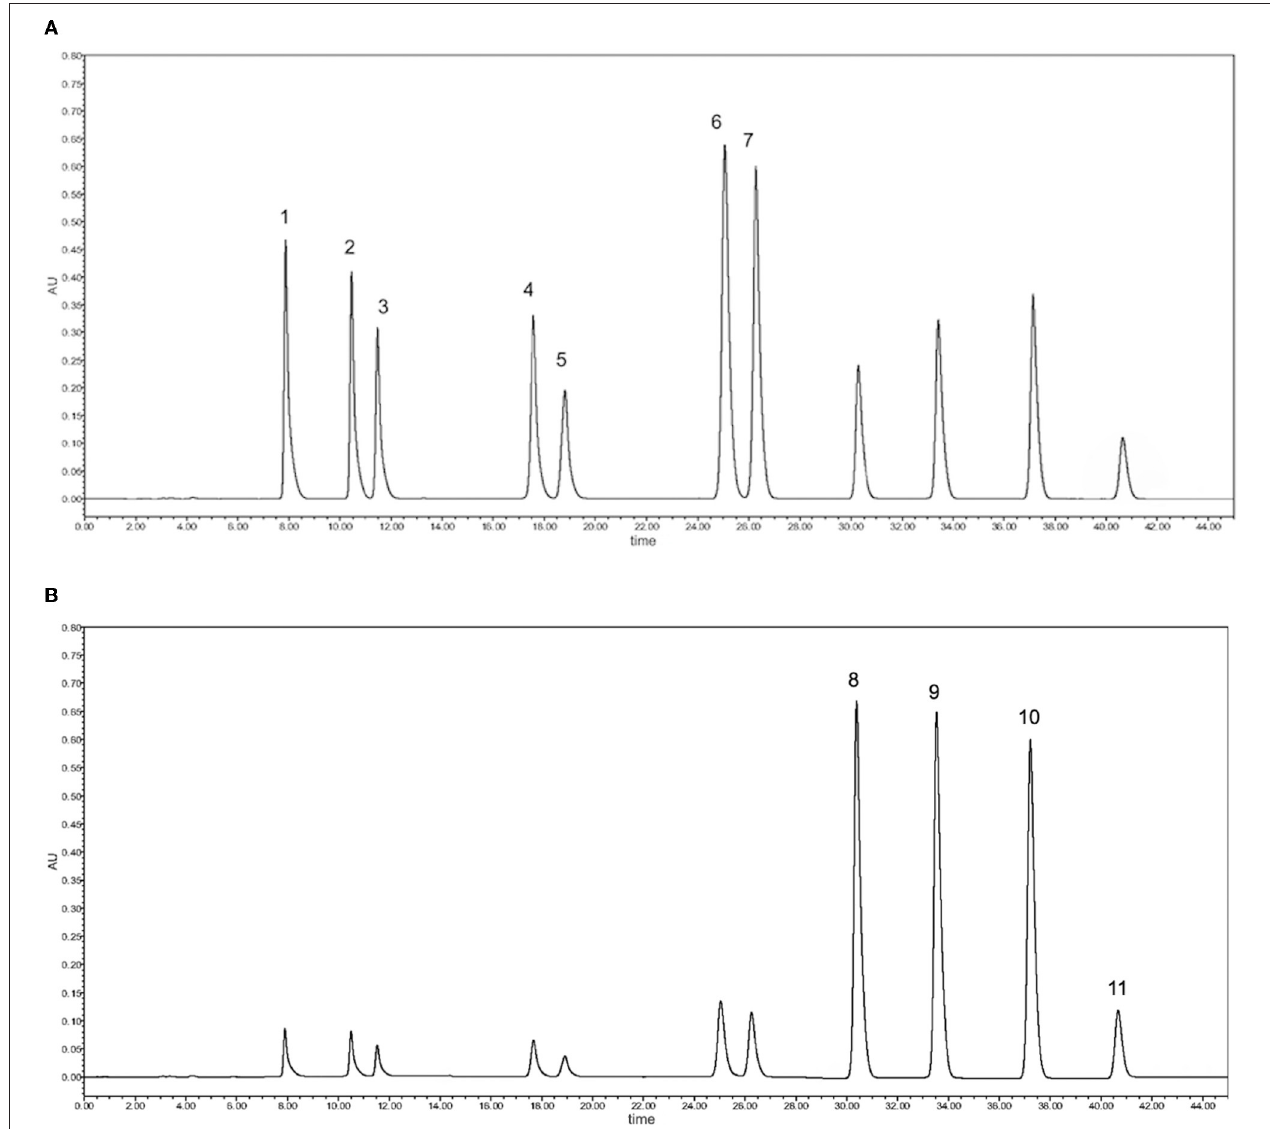
FIGURE 1 | Main flavanones and PMFs were quantified by HPLC-DAD. (A) Chromatogram of flavanone standards at 283 nm: 1, eriocitrin; 2, naringin; 3, hesperidin; 4, didymin; 5, poncirin; 6, naringenin; 7, hesperitin. (B) Chromatogram of PMF standards at 330 nm: 8, sinensetin; 9, nobiletin; 10, tangeretin; 11, 5-O-demethylnobiletin.